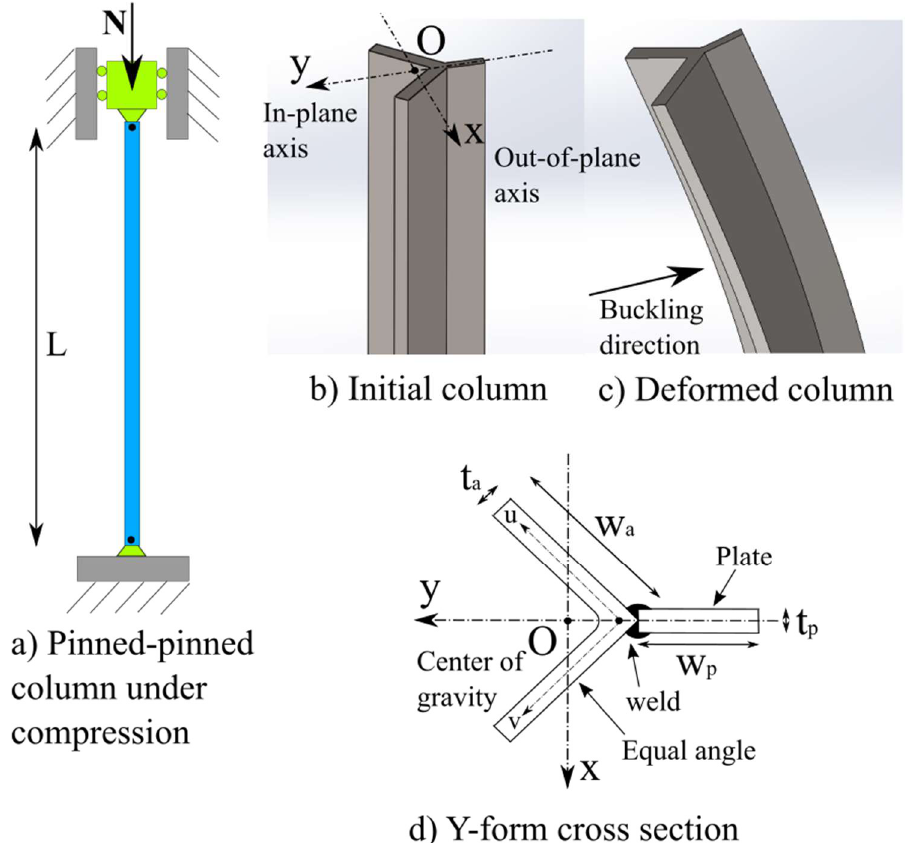
Figure 2. Description of column: ( a ) schematization of pinned–pinned column under axial loading; ( b ) 3D view of the initial Y-section column; ( c ) deformed column under compression; ( d ) geometry of the Y-form cross section.